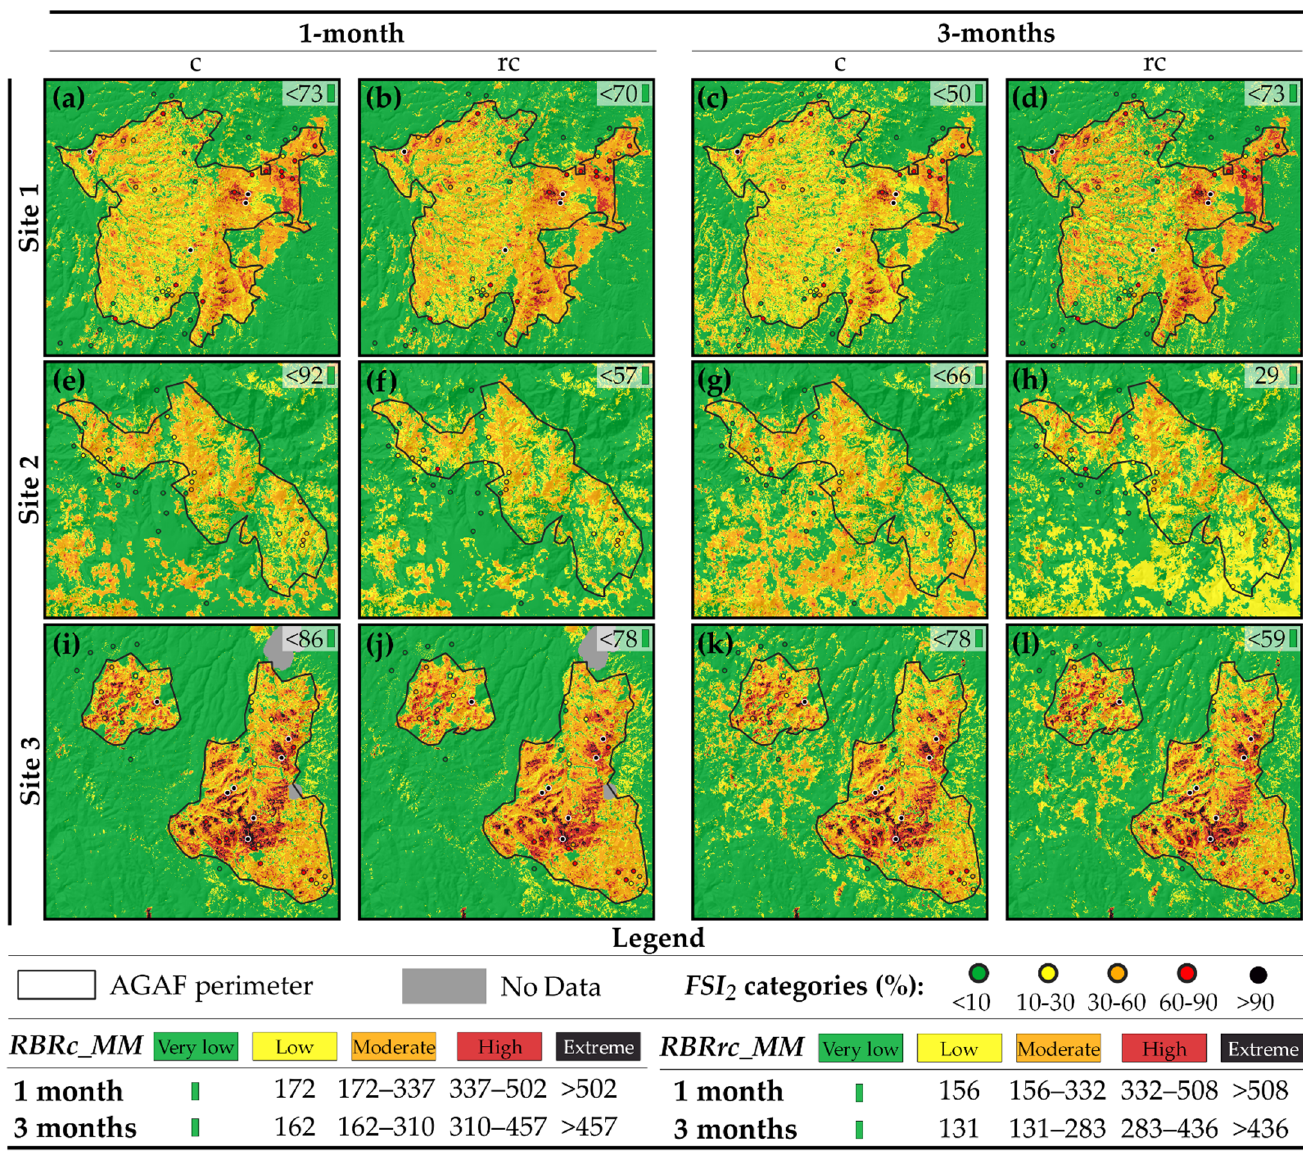
Figure 7. Fire severity mapping with MM technique and different time windows (1 and 3 months) and constant ( c ) or relative phenological correction ( rc ) for wildfires in Site 1 ( a – d ), Site 2 ( e – h ), and Site 3 ( i – l ), using FSI 2 thresholds (see Table S4). The corresponding burned area threshold (Very low/unburned, shown in green) was assigned for each wildfire (see Table 6) according to the time window and composite technique.